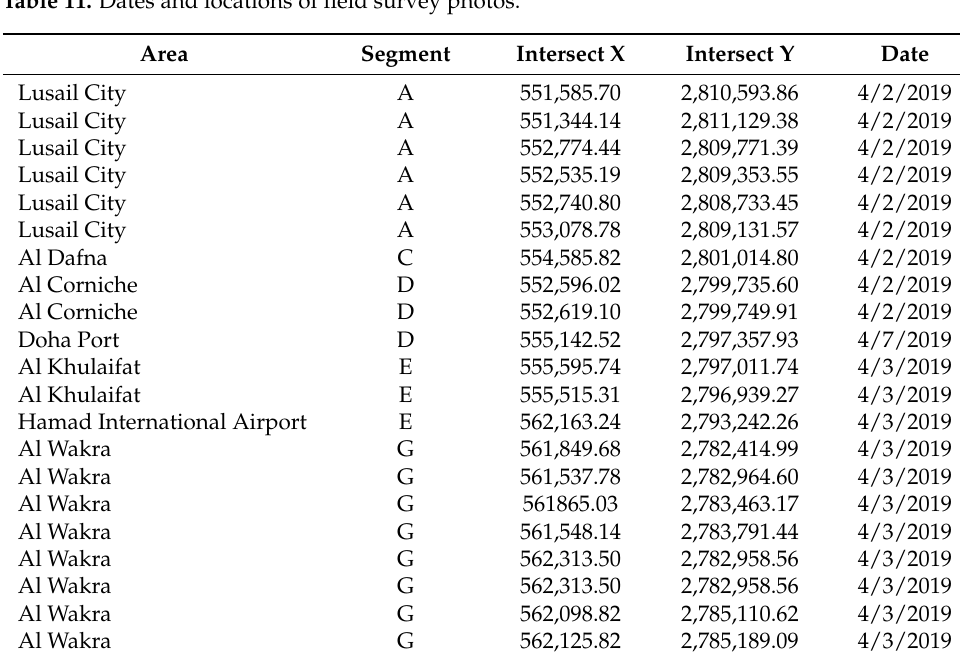
Figure 23. Dot map representing field survey locations. Table 11. Dates and locations of field survey photos.